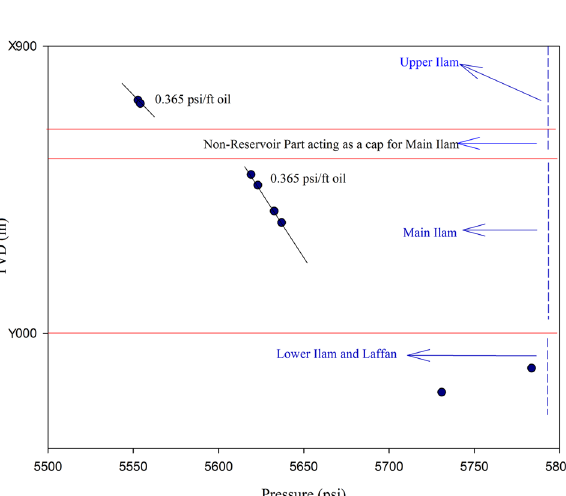
Fig. 4 Pressure–depth plot in Well B-4 in Ilam Formation before pro- duction from Field B. The pressure separations in Upper, Main and Lower Ilam prove the presence and effectiveness of basal Upper Ilam as a top seal for Main